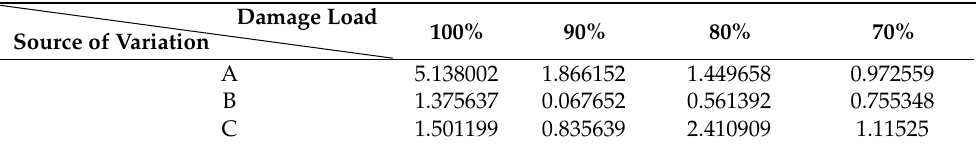
Table 10. F -values of the strength recovery rate after healing at aging for 28 d.